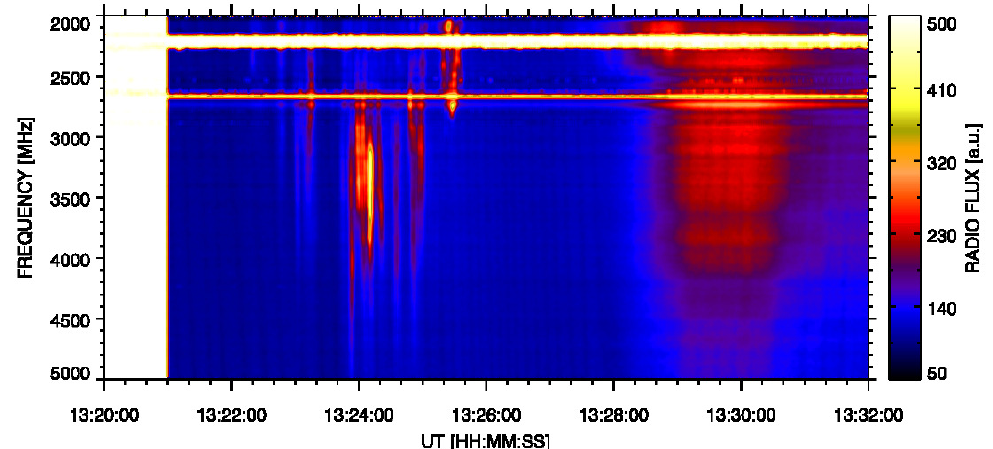
Figure 2. Global 150–5000MHz radio spectrum in the time interval 13:20–13:32UT observed during the 2 April 2022 flare: the 150–1000MHz ORFEES spectrum ( top panel), the 800–2000MHz Ondˇrejov spectrum ( middle panel), and the 2000–5000MHz Ondˇrejov spectrum ( bottom panel).